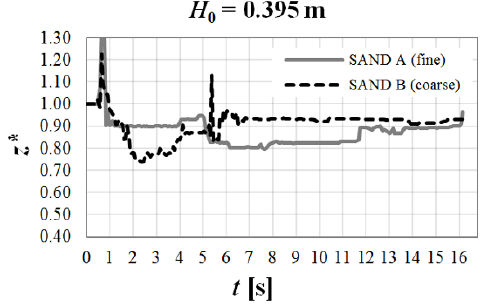
Figure 7. Experimental time evolution of z * at the dike upstream reference abscissa ( −δ ) for Tests A3 and B3.